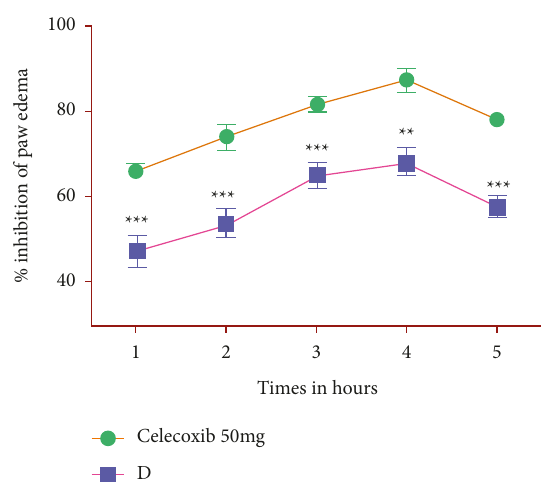
Figure 5: Percent inhibition produced by compound D (100mg/ kg) in the prostaglandin E 2 -induced paw edema model in mice. Each percent point represents the mean SEM for a group of 8 mice. Data were analyzed by ANOVA followed by post hoc Dunnett’s test. Asterisks show significant values from phlogistic ± agent prostaglandin E 2